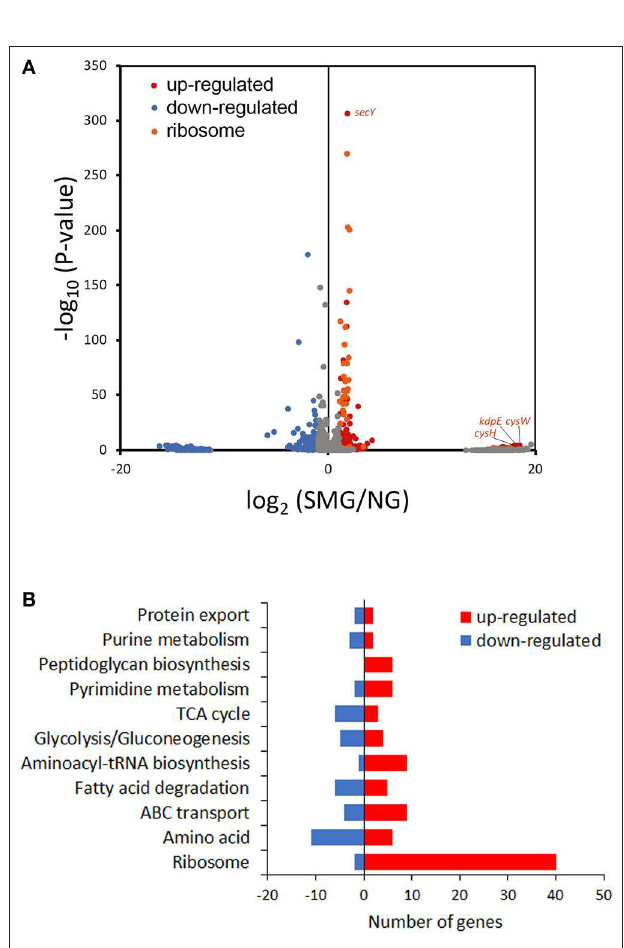
FIGURE 4 | Transcriptome analysis. (A) Volcano plot of the transcriptome data. (B) DEG numbers in the most differential Kyoto Encyclopedia of Genes and Genomes